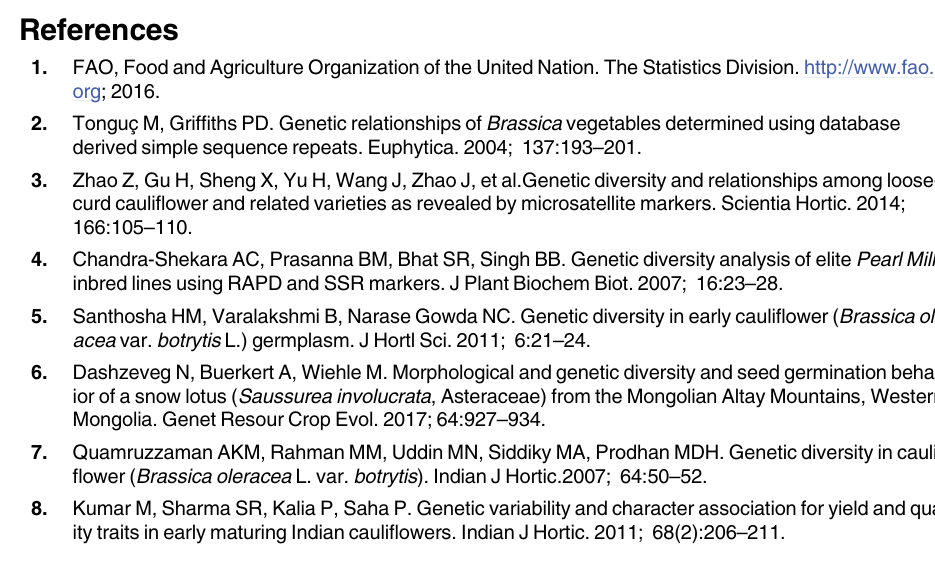
S2 Table. The sequences, annealing temperature, number of alleles (Na), effective number of alleles (Ne), Shannon’s Information index (I) and polymorphism information content (PIC) per locus of the polymorphic SSR markers. S3 Table. Nei’s (1972) genetic distance matrix data calculated for the 165 cauliflower inbred lines on the basis of the SSR markers. S4 Table. The LnP(D) (log-likelihood) function value calculated by the STRUCTURE pro- gram for determining a suitable K